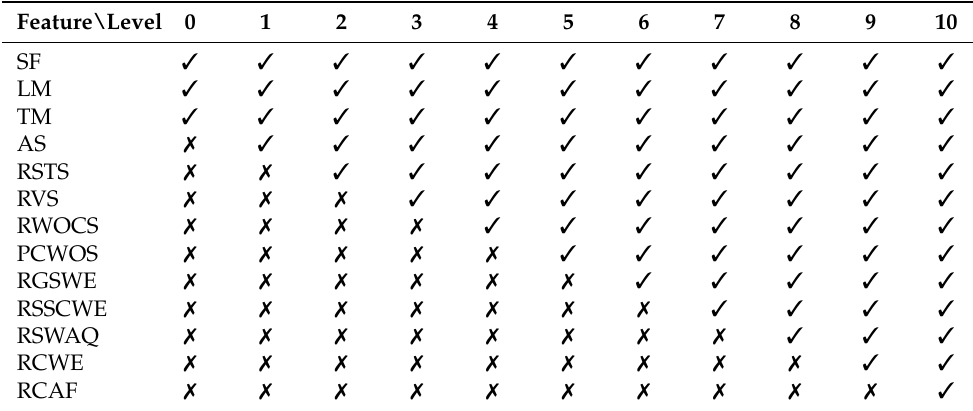
Table 1. Mapping of aphasic speech severity level with speech features. Feature\Level